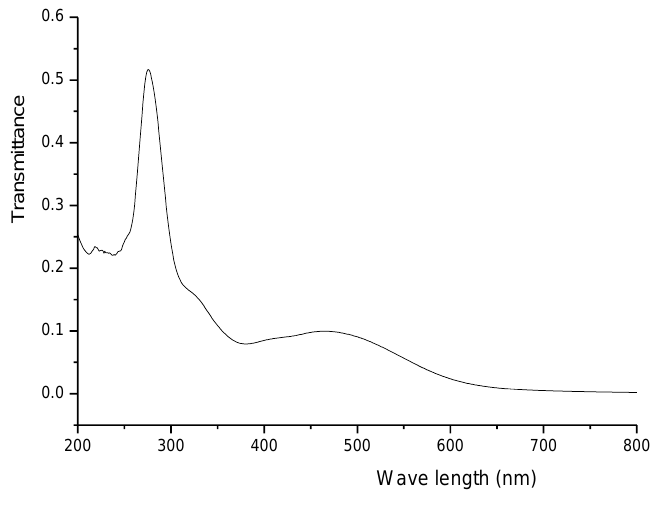
Fig. S5. UV-Vis spectrum of complex 1 .